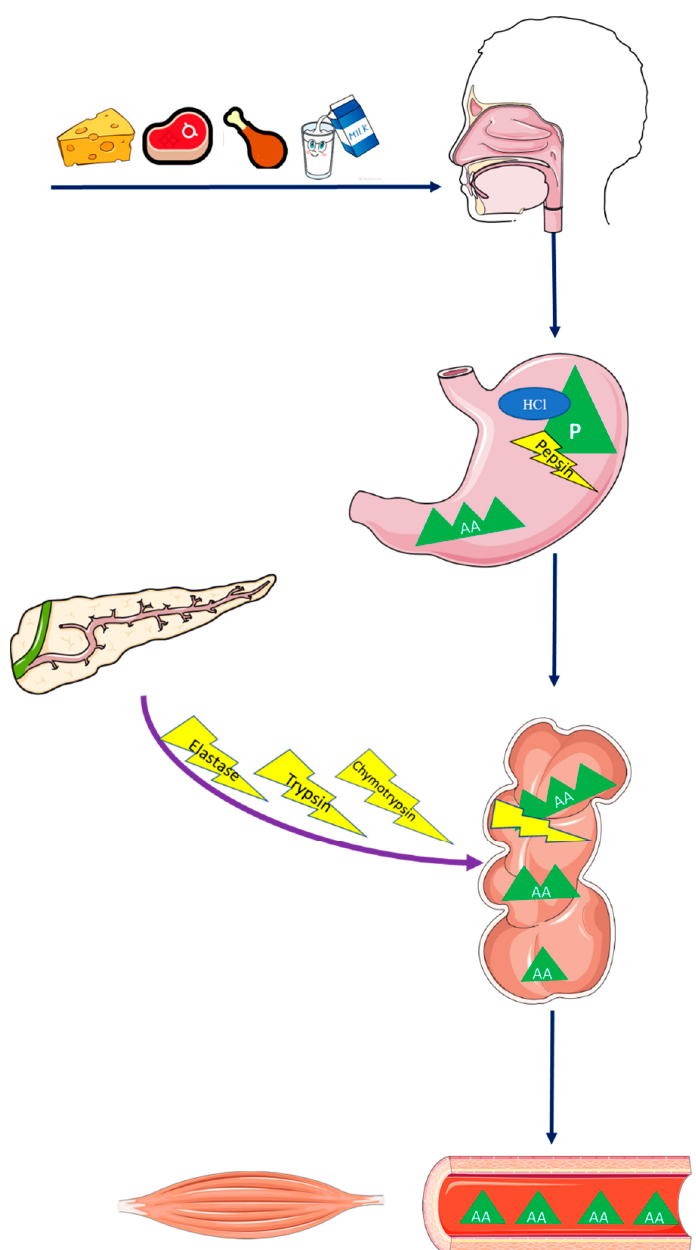
Figure 1. Protein absorption and digestion. Abbreviations: AA, amino acid; HCl, hydrochloric acid; P, protein.